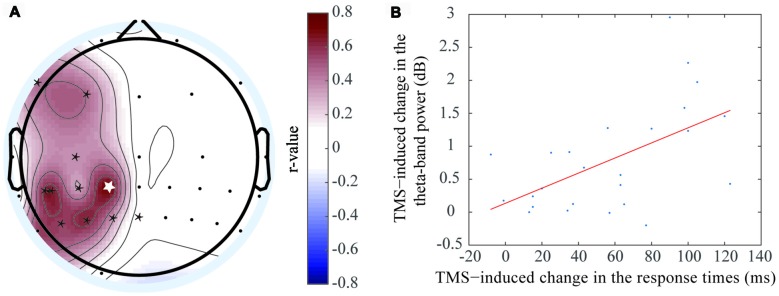
Positive correlation was exhibited between the event-related spectral perturbation (ERSP) value difference of the theta oscillation and response time (RT) difference. (A) The electrodes with significant positive correlations included F7 (r = 0.425, P < 0.05*), F3 (r = 0.451, P < 0.05*), C3 (r = 0.356, P < 0.05*), CP3 (r = 0.621, P < 0.05*), CP1 (r = 0.715, P < 0.01**), CP5 (r = 0.657, P < 0.01**), P5 (r = 0.546, P < 0.05*), P3 (r = 0.553, P < 0.05*), P1(r = 0.625, P < 0.05*), and Pz (r = 0.356, P < 0.05*). (B) The correlation at the CP1 electrode, which was shown in figure (A) with the white asterisk.